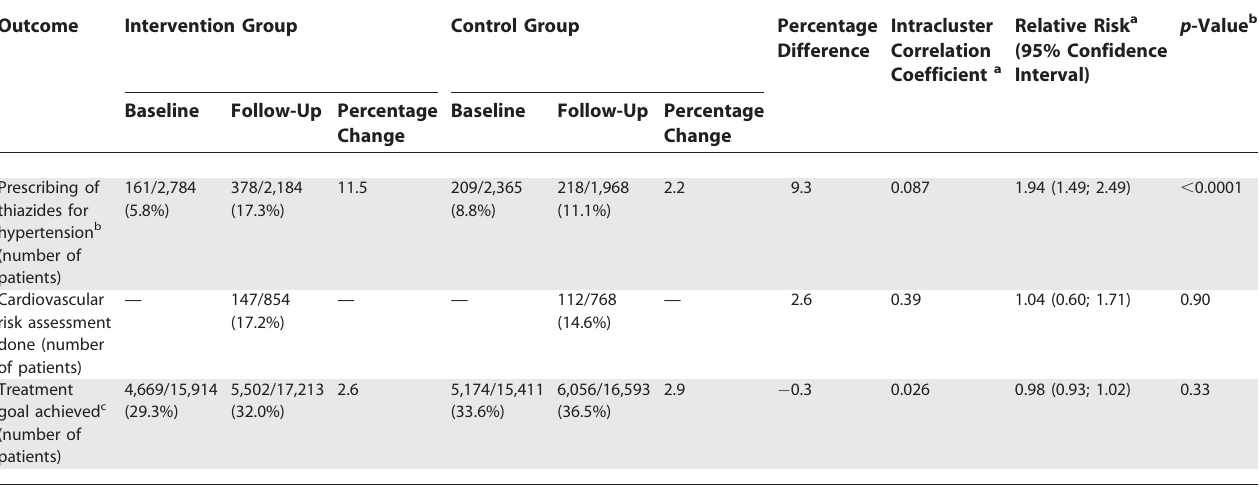
Table 1. Main Results from Intervention Trial